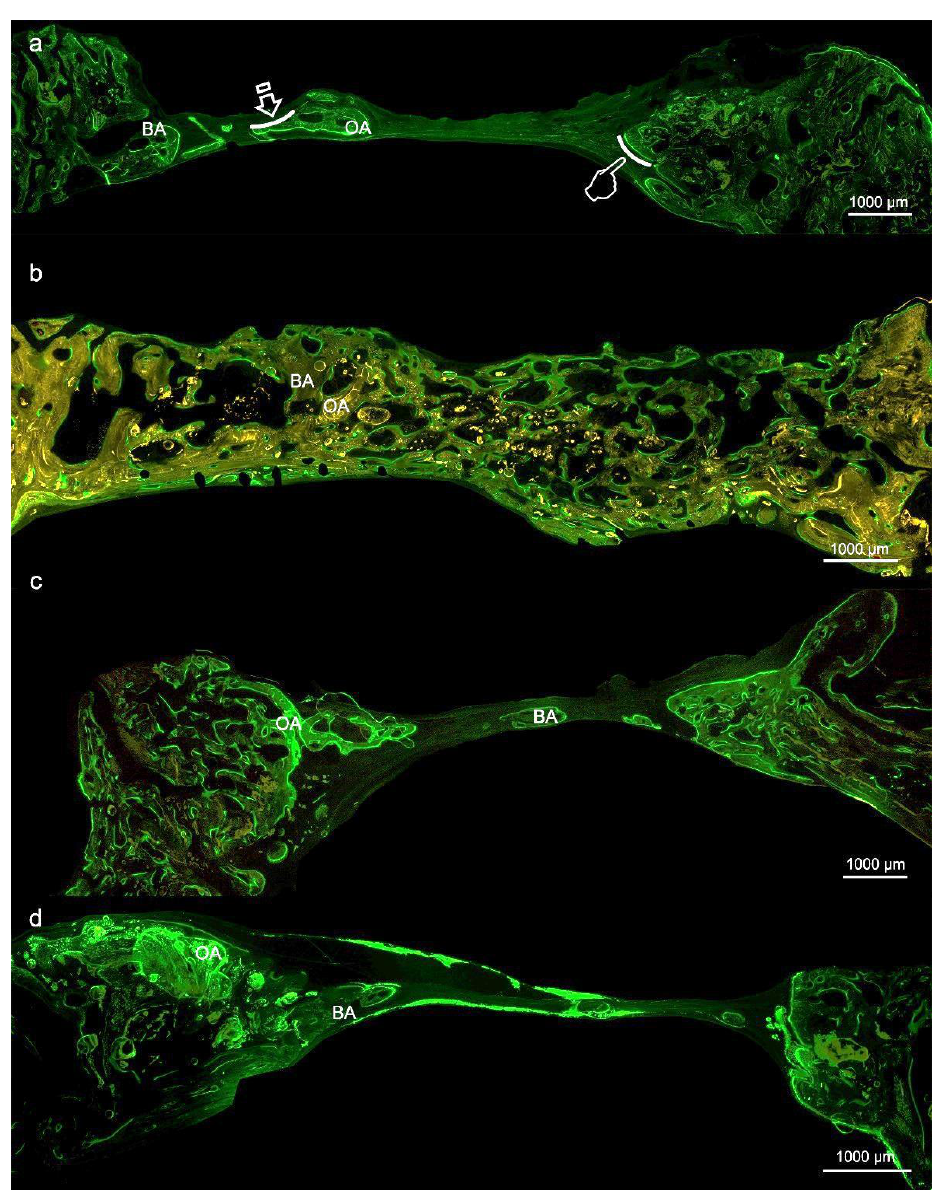
Figure 2. Bone histology obtained by fluorescence with calcein at the region of interest to see mineralized bone, at six weeks of healing time after using HOOC-Si ( a ), Zn-HOOC-Si ( b ), Dox-HOOC-Si; ( c ) loaded membranes, and control (no membrane) ( d ). Arrows indicate bone perimeter ( BP ). Pointers indicate osteoid perimeter ( OP ). BA , bone area; OA , osteoid area. Table 3. Histomorphometric data acquired by fluorescence with calcein, within the new bone created at the region of interest (Mean ± Standard Error).